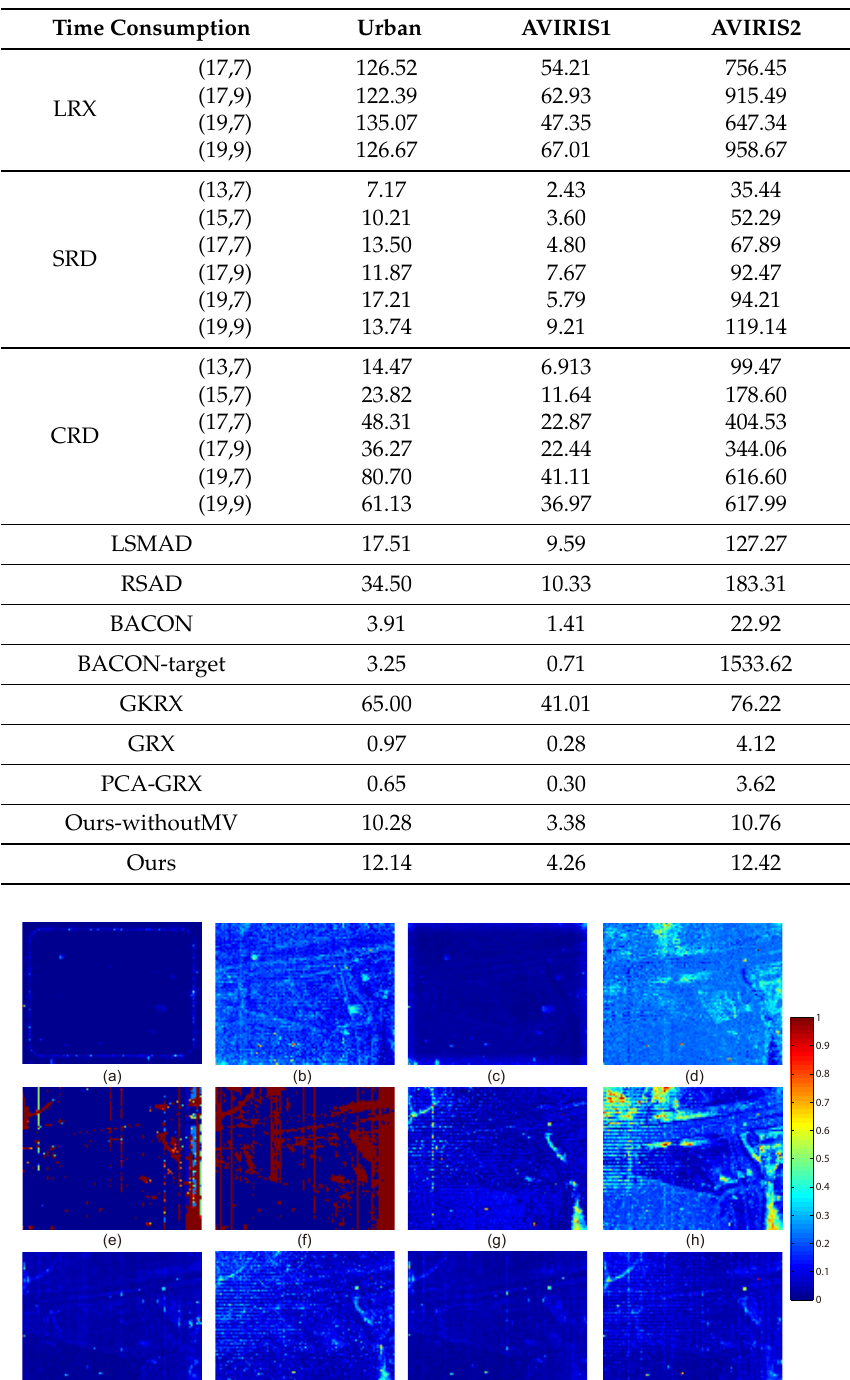
Table 2. Time consumption (seconds) of all the competitors on three hyperspectral images including Urban data set, AVIRIS1data set, and AVIRIS2 data set.